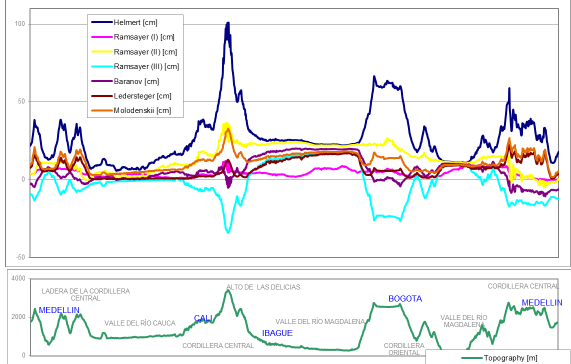
Figure 2. Magnitude of the gravity reductions (top) for a levelling line with heights up to 4000 m. Orthometric reductions were calculated after Helmert (Heiskanen and Moritz 1967), Ramsayer (1953, 1954), Baranov (Leismann et al. 1992) andLedersteger(1956). NormalreductionsafterMoloden- skii (Leismann et al. 1992) are included for comparison. Data taken from Sánchez